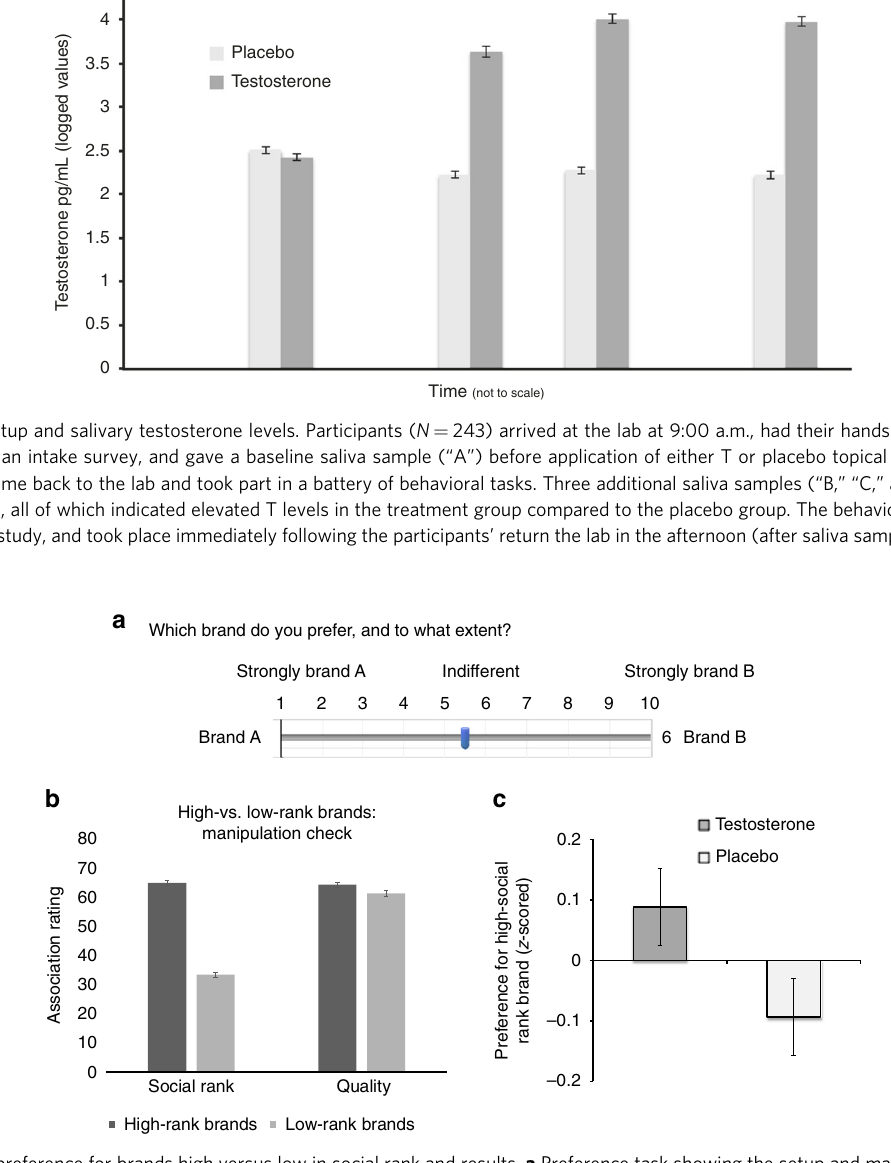
Fig. 2 Task to assess preference for brands high versus low in social rank and results. a Preference task showing the setup and main dependent variable. b Mean social rank and quality association ratings of brands pre-classi fi ed based on a pretest as high vs. low rank, by main study participants ( N = 243); perceived differences in social rank associations between the brands were substantially greater than the difference in perceived quality. c Mean preference toward the high (versus low) social rank brands for the two treatment groups ( z -scored at the pair level). Error bars denote s.e.m. For the corresponding dot plot, see Supplementary Fig. 2